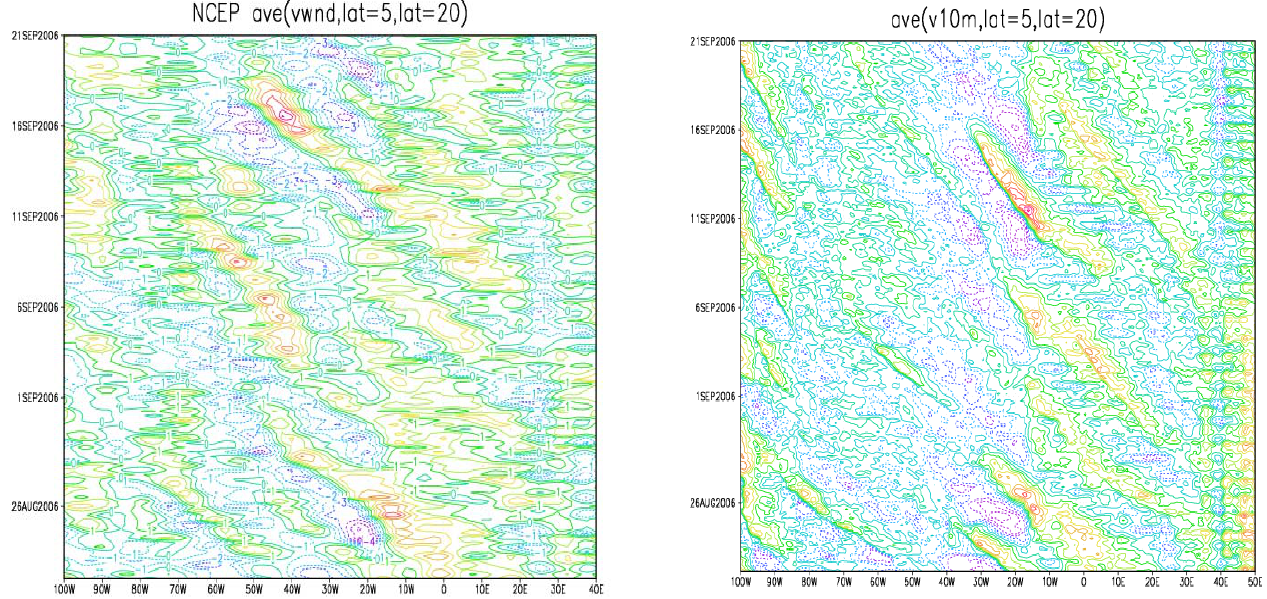
Fig. 5. Time-longitude sections of meridian winds averaged over latitudes 5–20N from 22 August to 21 September 2006. (a) NCEP reanalysis. (b) a 30-day simulation initialized at 00:00UTC 22 August 2006 with the high-resolution fvGCM.